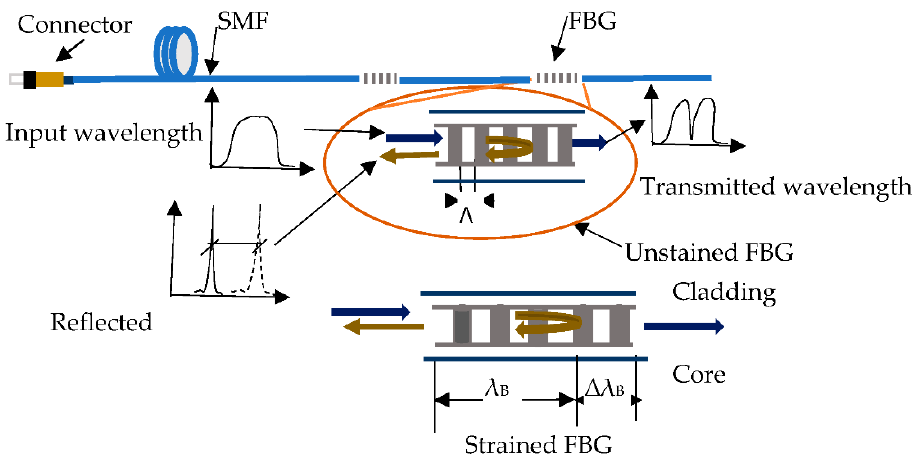
Figure 1. Working principle of fiber Bragg grating (FBG) sensors.